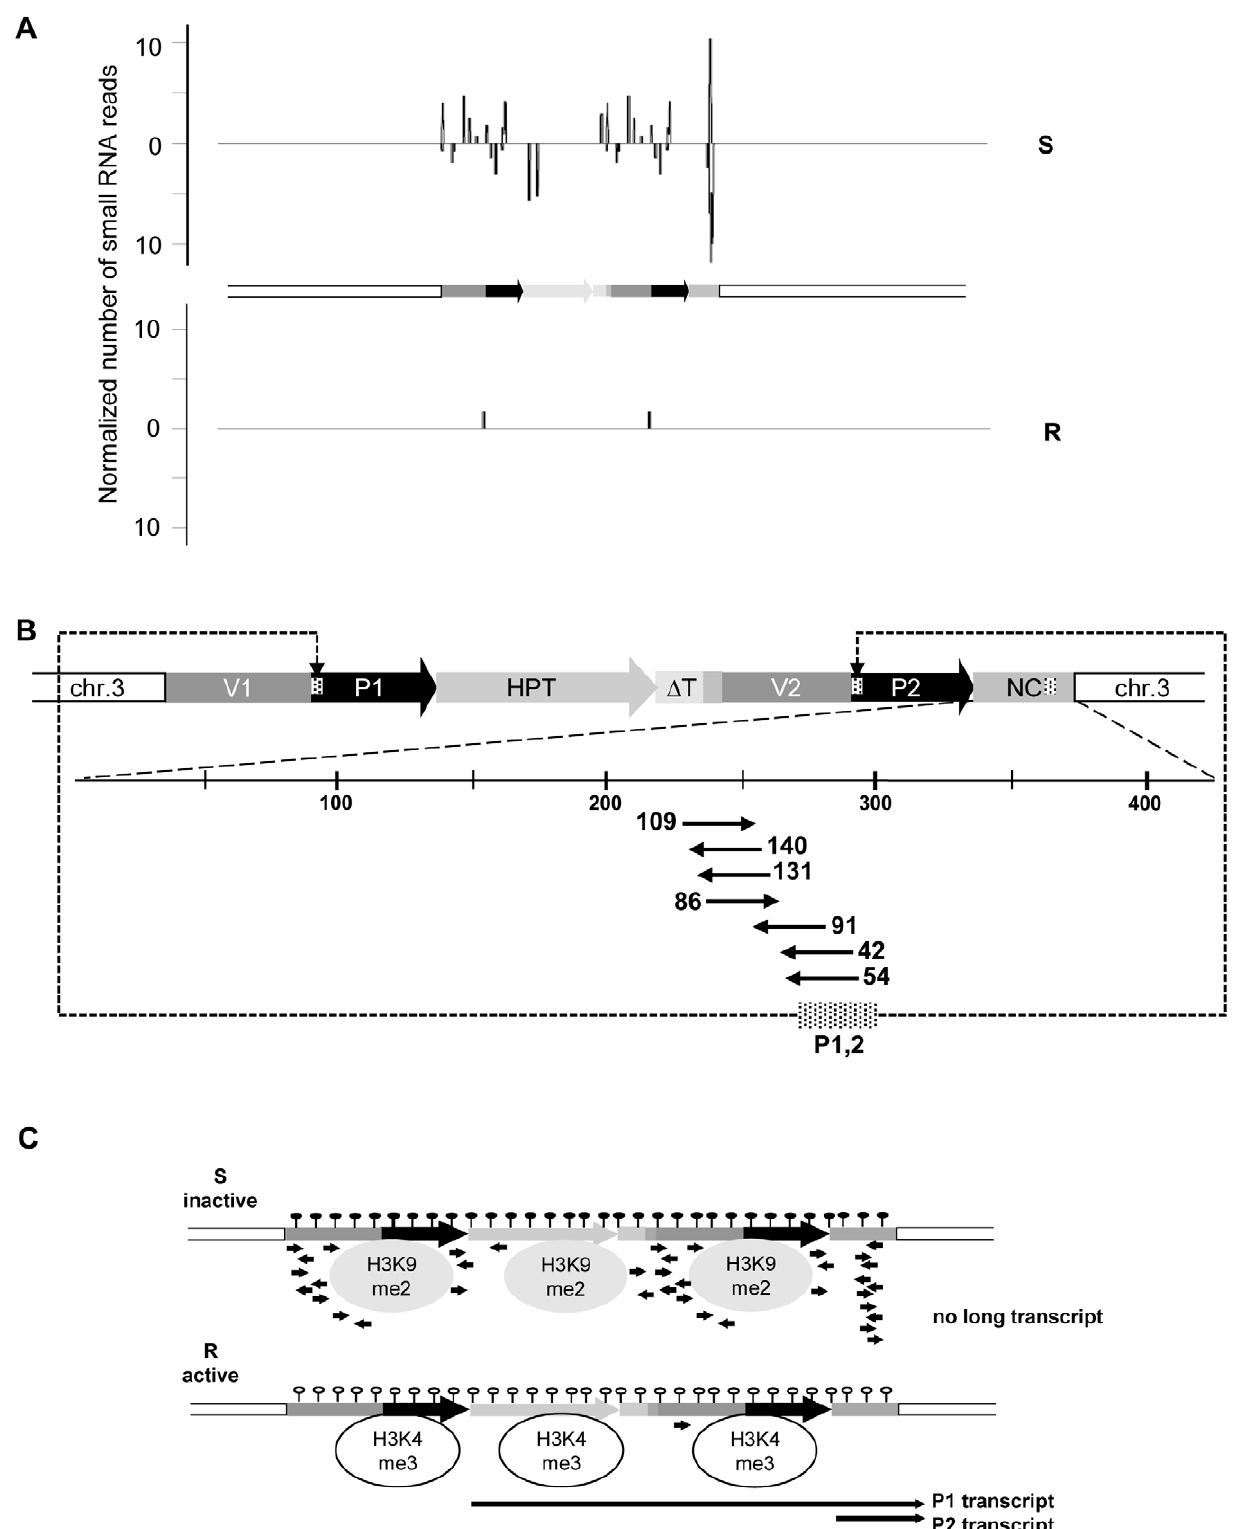
Figure 2. Epialleles differ in small RNA reads. (A) Abundance and location of small RNAs with homology to the inactive (S) and active (R) epiallele. Sense and antisense orientation are indicated above and below the horizontal lines, respectively. (B) Detailed view on the P2 transcript region and number of specific reads per million reads. Dashed region in P1, P2 and NC: position and overlap of reads with the promoter region. (C) Scheme of chromatin organization and RNA abundance at the inactive (S) and the active (R) epiallele. Filled and empty lollipops: presence or absence of DNA methylation; H3K9me2 and H3K4me3: modifications typical for transcriptionally silent and active chromatin, respectively; black arrows: RNA. doi:10.1371/journal.pgen.1002331.g002 PLoS Genetics | www.plosgenetics.org